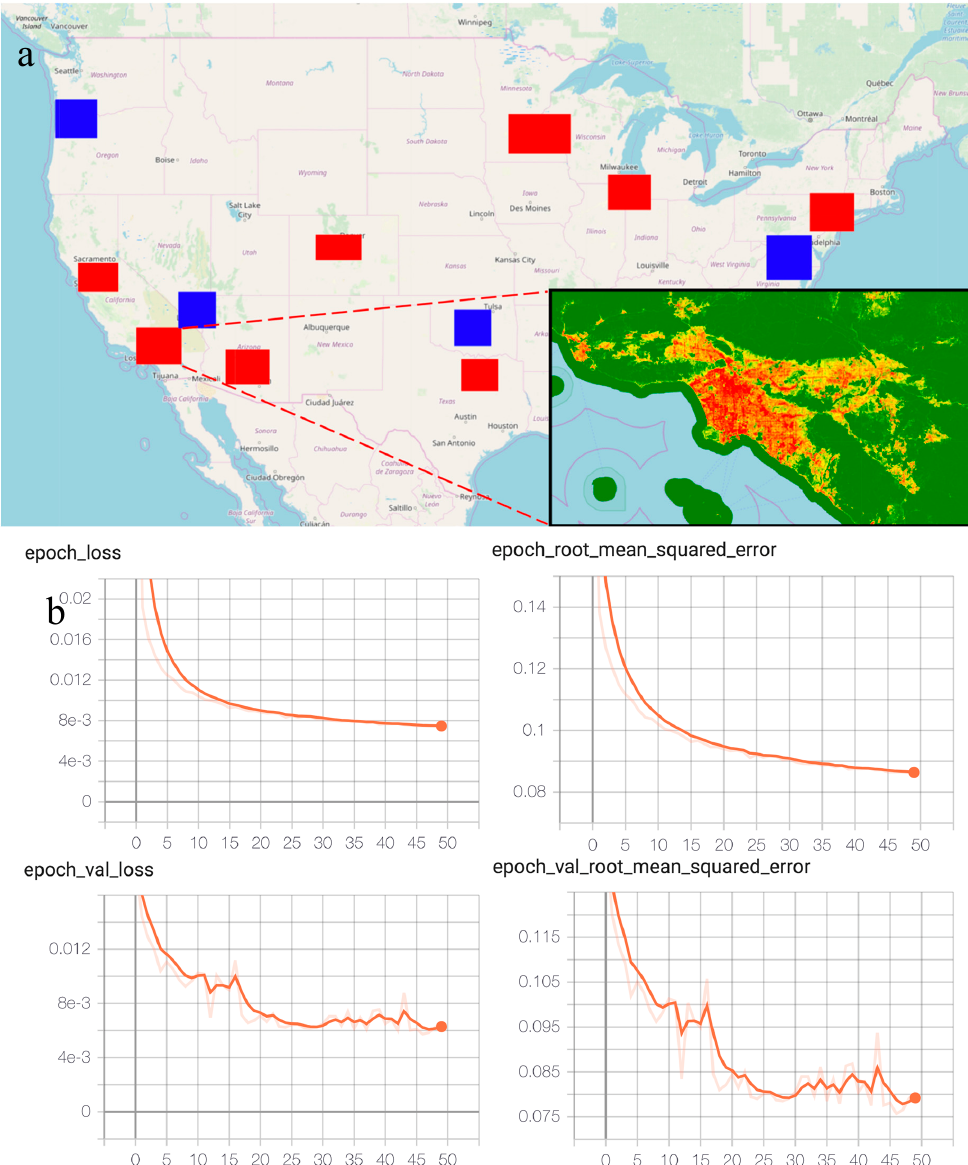
Figure 2. ( a ) Locations of the sampling polygons on the United States map, red for training polygons, blue for evaluation. The map on the right bottom shows the impervious surface percentage (red as 100% and green as 0%) region of the Metropolitan Los Angeles; ( b ) the charts of the modeling process regards of loss function and root mean squared error for the training (upper) and evaluation (lower) datasets. The lighter lines show the calculated values from the loss function and the darker lines show the smoothed values (y-axis) for each epoch (x-axis).